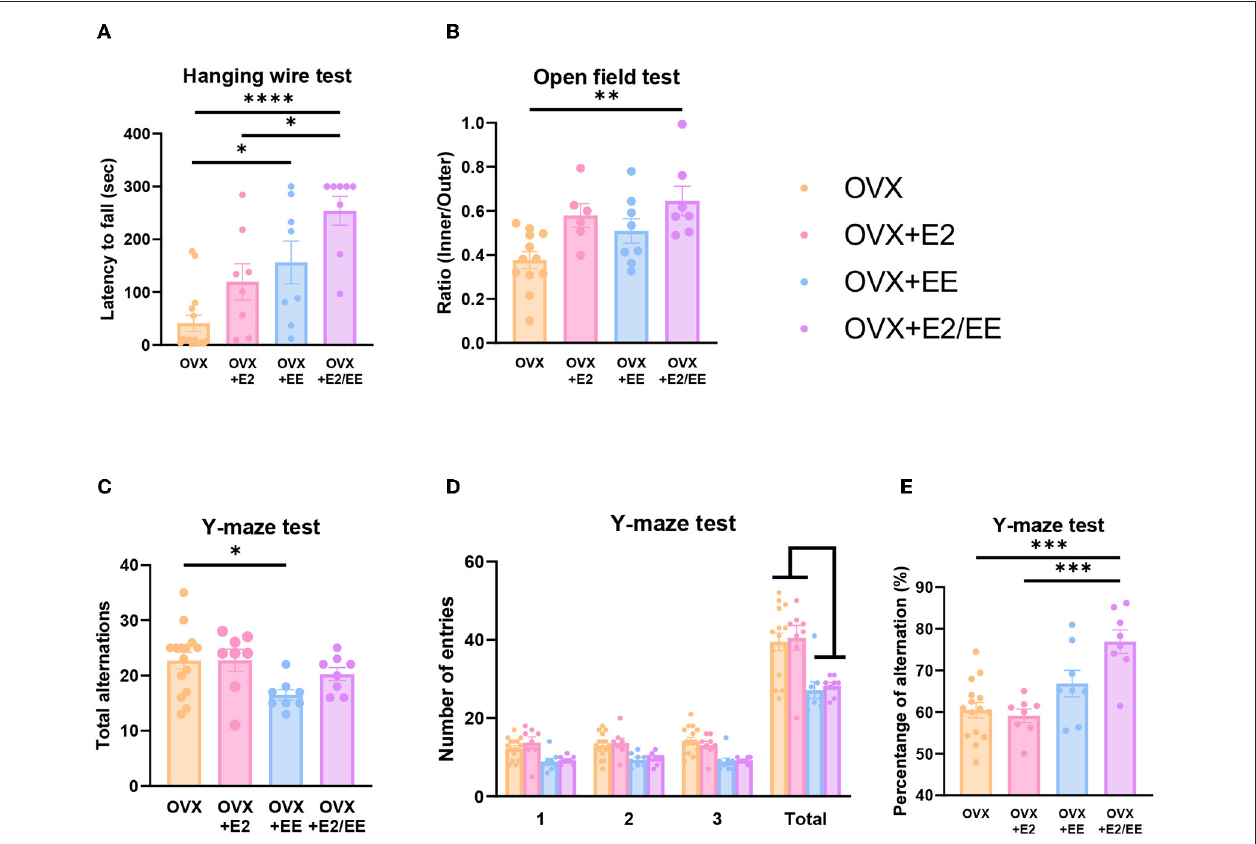
FIGURE 13 | Synergistic effects of estrogen and EE on functional improvement in OVX models. Behavioral test assessments conducted in the OVX groups. (A) Hanging wire test, hippocampus ( n = 8–15 per group). (B) Open field test ( n = 6–12 per group). (C) Number of alternative behaviors, (D) number of entries, and (E) percent alternation of Y-maze test (8–15 per group). One-way ANOVA with Tukey multiple comparison test. Data represented are means ± SEM. * p < 0.05, ** p < 0.01, *** p < 0.001, and **** p <